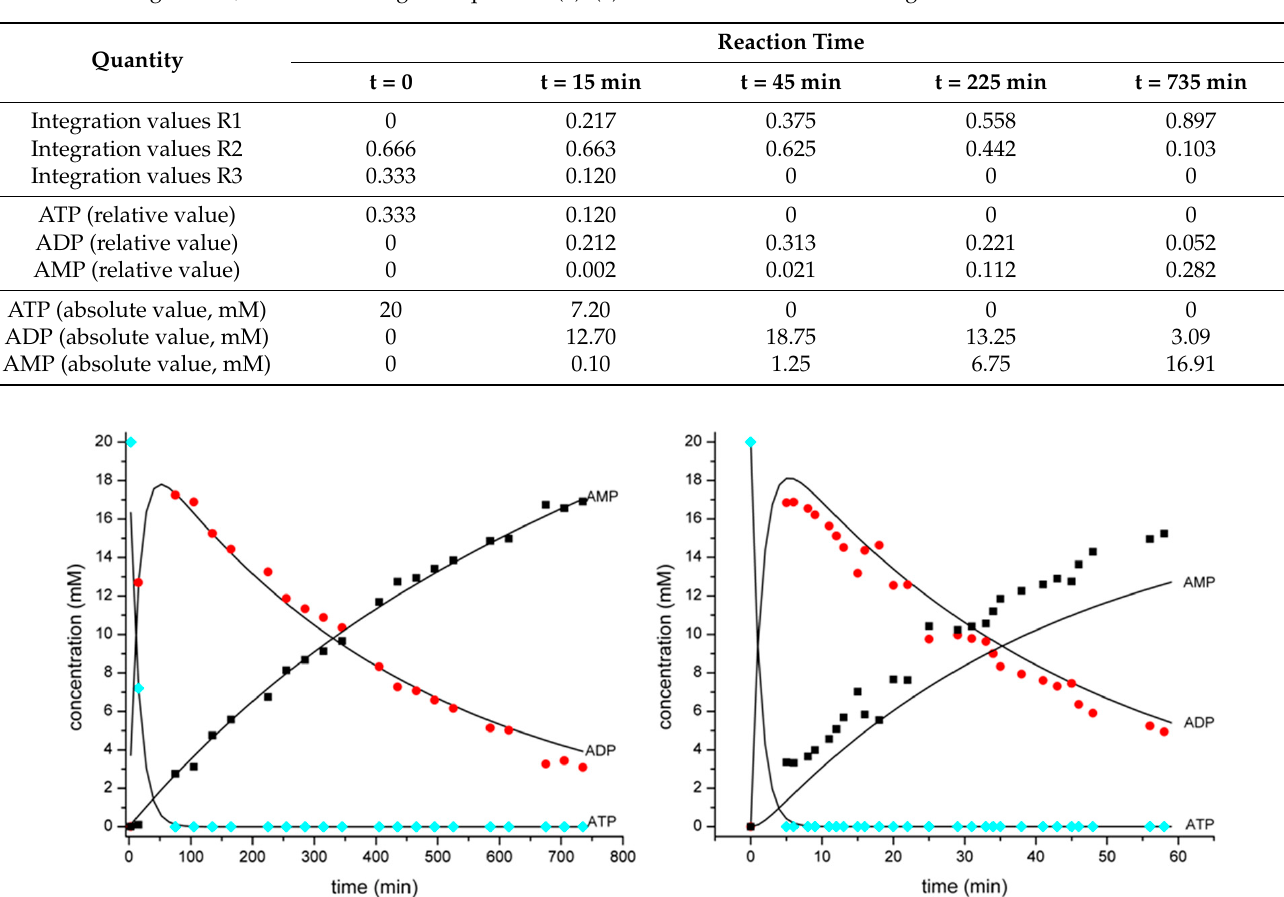
Table 2. Representative calculation of ATP, ADP and AMP concentrations for different time points based on the integration values of regions R1, R2 and R3 using the Equations (1)–(3) of the main text. ATP starting concentration = 20 mM.